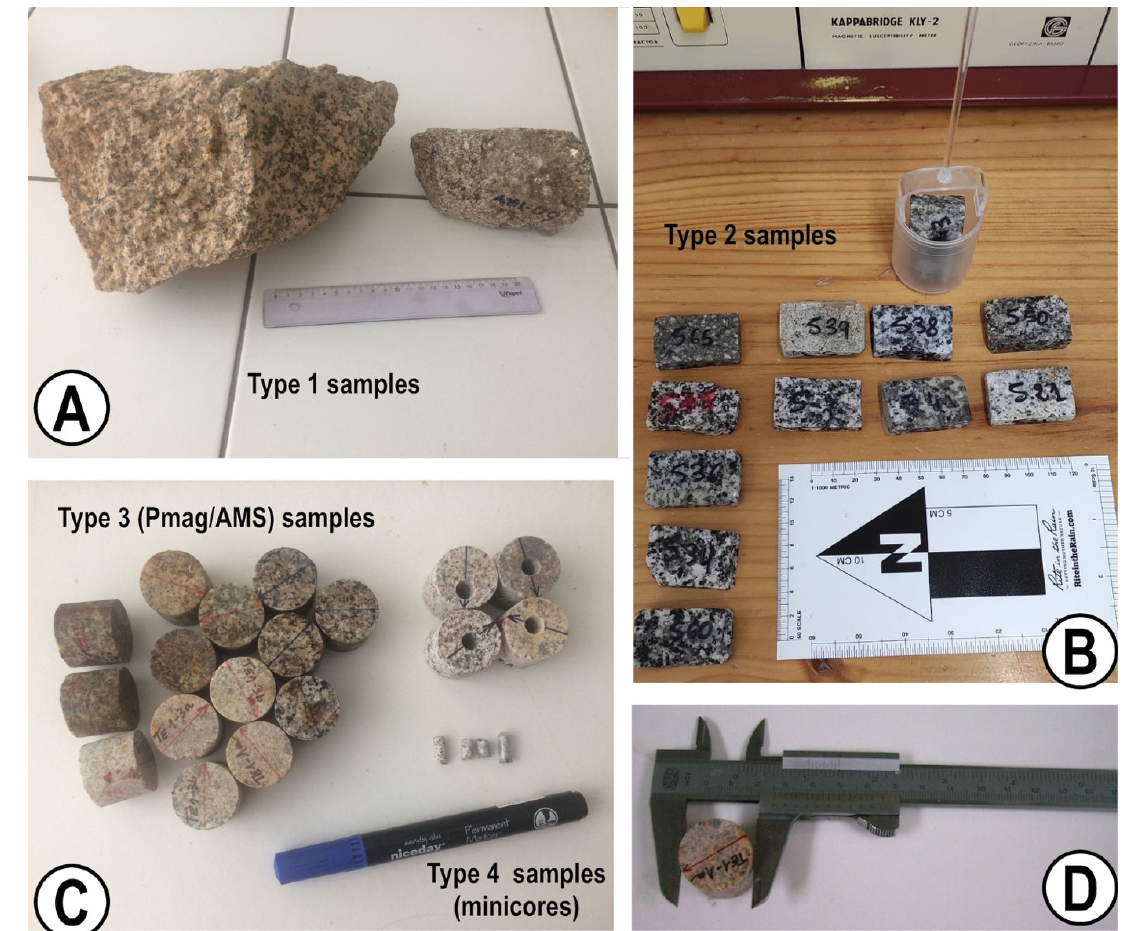
Figure 4. Types of petrophysical samples. Type 1 hand samples ( A ), type 2 mini blocks ( B ) and types 3 standard paleomagnetic-AMS samples ( C ) and subsampling for magnetometers (type 4). ( D ) Caliper estimate of diameter of type-3 samples.